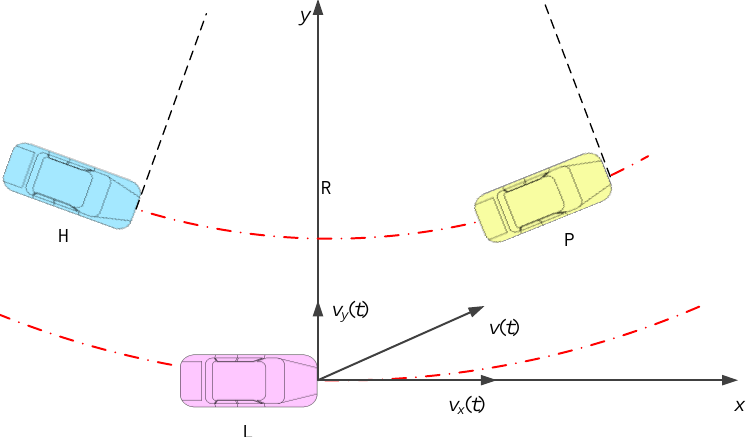
is the origin, the X axis points to the direction of the vehicle, and the Y axis that is perpendic- ular to the X axis points to the target lane. Therefore, longitudinal acceleration, longitudinal velocity, longitudinal position, and lateral position are expressed as a i ( t ) , v i ( t ) , x i ( t ) and y i ( t ) , respectively, where i ∈ { H , L , P } . Similarly, the longitudinal distance and the lateral vehicle to the origin of the coordinate